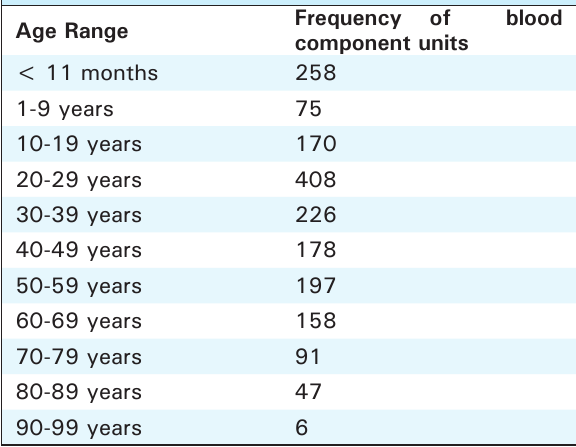
Table 1. Distribution of blood component units depending upon